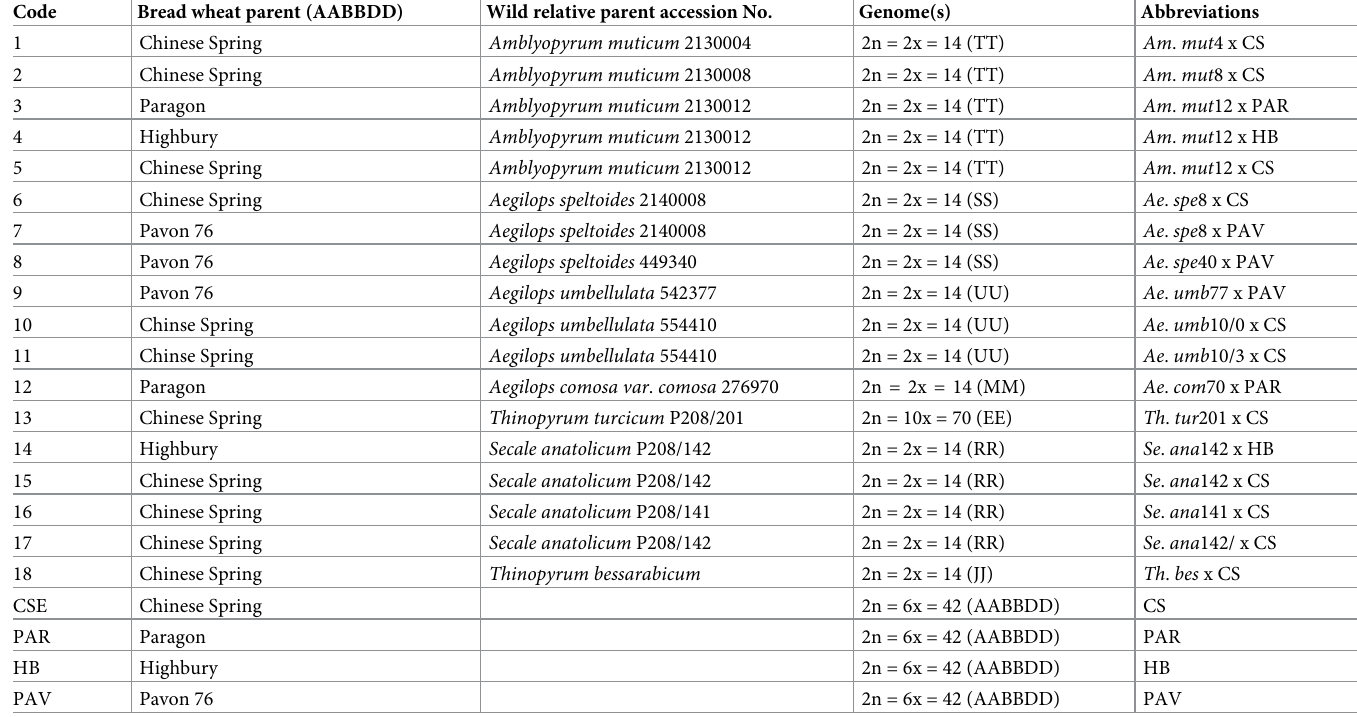
Table 1. Eighteen amphidiploid lines with the wild parent accessions and bread wheat parents used to produce the amphidiploid lines. Code Bread wheat parent (AABBDD) Wild relative parent accession No. Genome(s)